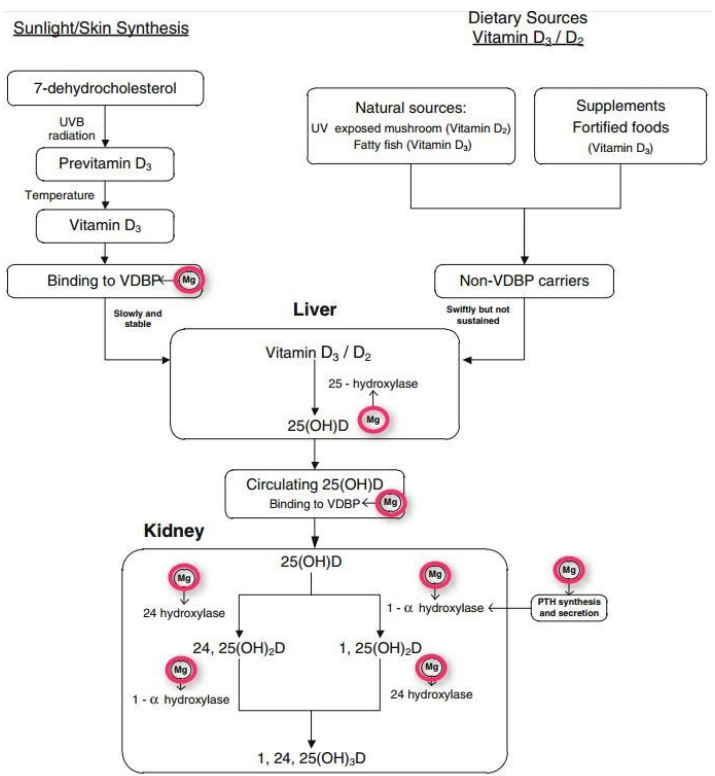
Figure 1. Magnesium is required for the synthesis of the active form of vitamin D and PTH.